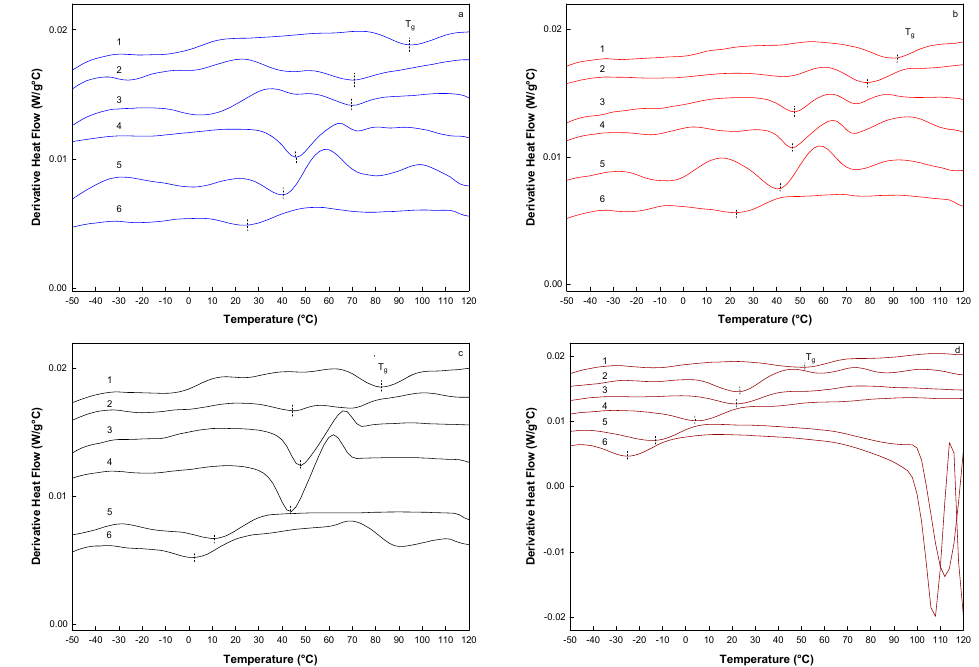
Figure 4. Thermograms of the first derivative of the MDSC for the MXs at the different a w . ( a ) Mc; ( b ) M10; ( c ) M20; and ( d ) M40. Water activities are indicated by the numbers: (1) 0.070, (2) 0.328, (3) 0.434, (4) 0.532, (5) 0.718, and (6) 0.75. The small dotted vertical line on each curve indicates the temperature at which T g was determined.